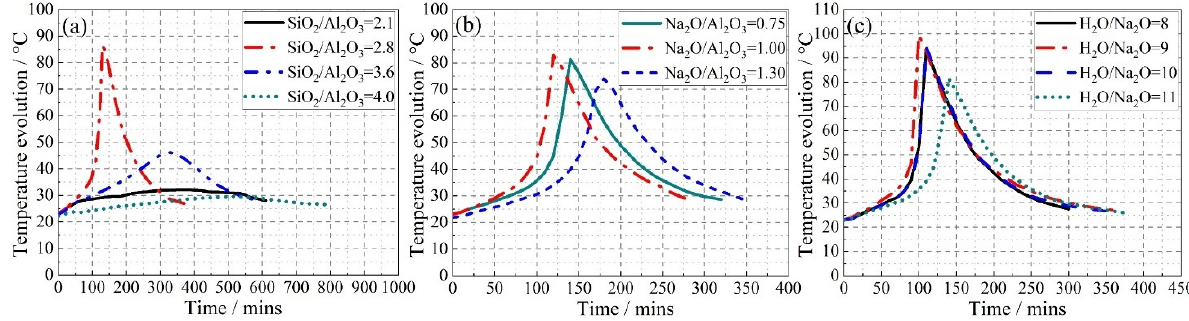
Figure 3. Temperature evolution as a function of time for fresh geopolymer mixture made with varying ( a ) SiO 2 /Al 2 O 3 , ( b ) Na 2 O/Al 2 O 3 , ( c ) H 2 O/Na 2 O molar ratios.